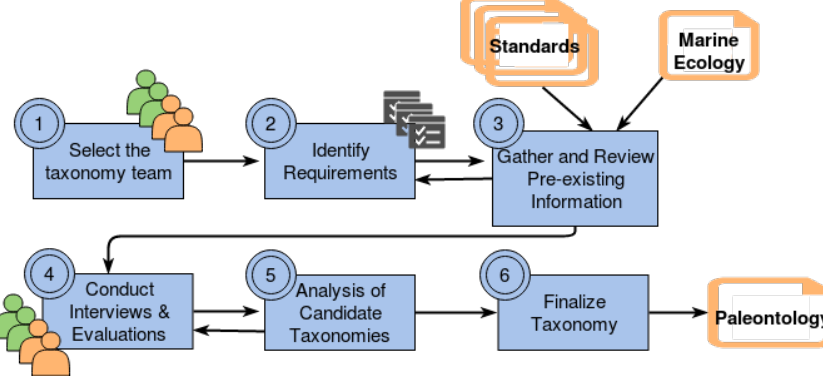
Figure 7. Steps for taxonomy development according to available